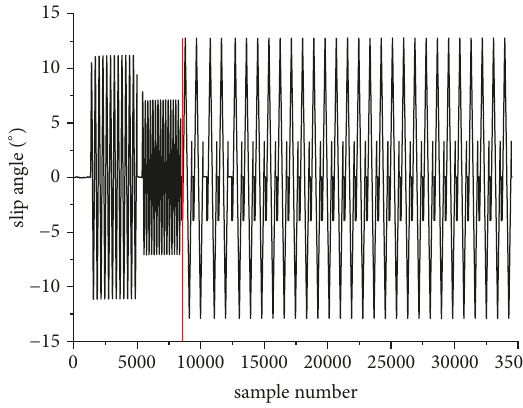
Figure 1: Relationship between slip angle and sample